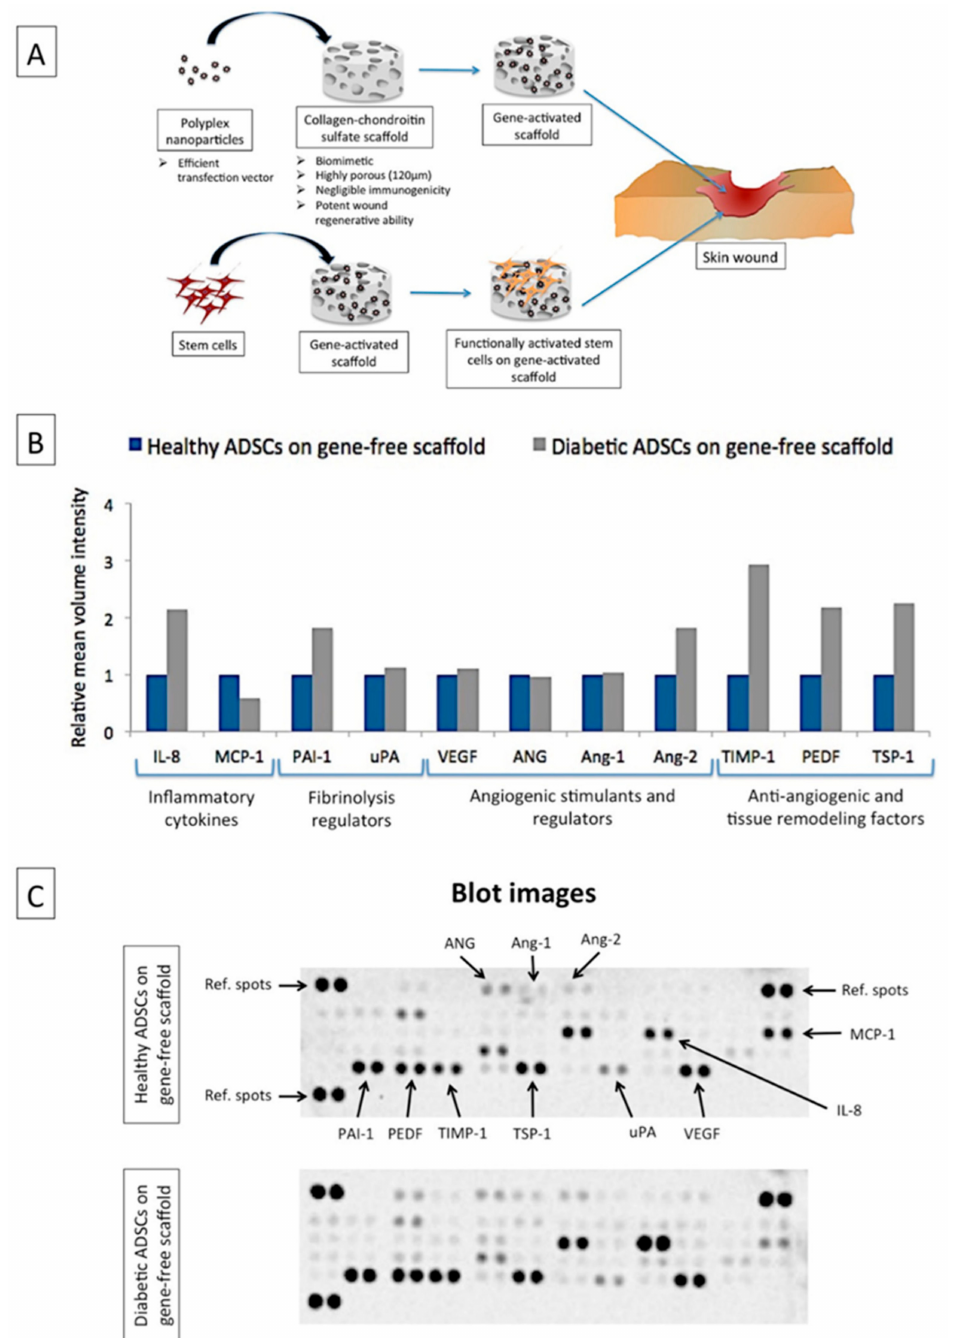
Figure 1. Gene-activated scaffold for wound healing applications and its impact on human adipose-derived stem cells (AD- SCs). ( A ) A schematic of the application of a gene-activated scaffold for wound healing. Gene-activated scaffolds can be directly implanted into the wound where host cells infiltrating the gene-activated scaffold induce the reparative effects. Alternatively, the tissue engineering approach can be adopted where stem cells are grown on the gene-activated scaffold and the resulting construct is implanted into the wound site. ( B ) Relative expression of functional factors produced by human diabetic ADSCs on the gene-free scaffold compared to healthy ADSCs on the gene-free scaffold on day 7. An angiogenesis proteome profiler was used to screen the contents of the ADSCs secretome. Conditioned media (CM) were pooled in equal volumes from the three replicates to assay the proteome. Expression levels were quantified based on mean volume intensities determined using a ChemiDoc system. The diabetic ADSCs on the gene-free scaffold produced elevated levels of anti-angiogenic factors (PAI-1, TIMP-1, PEDF and TSP-1), inflammatory cytokine IL-8 and vascular disruptive factor Ang-2 relative to their healthy equivalent. ( C ) Representative blot images of the proteome